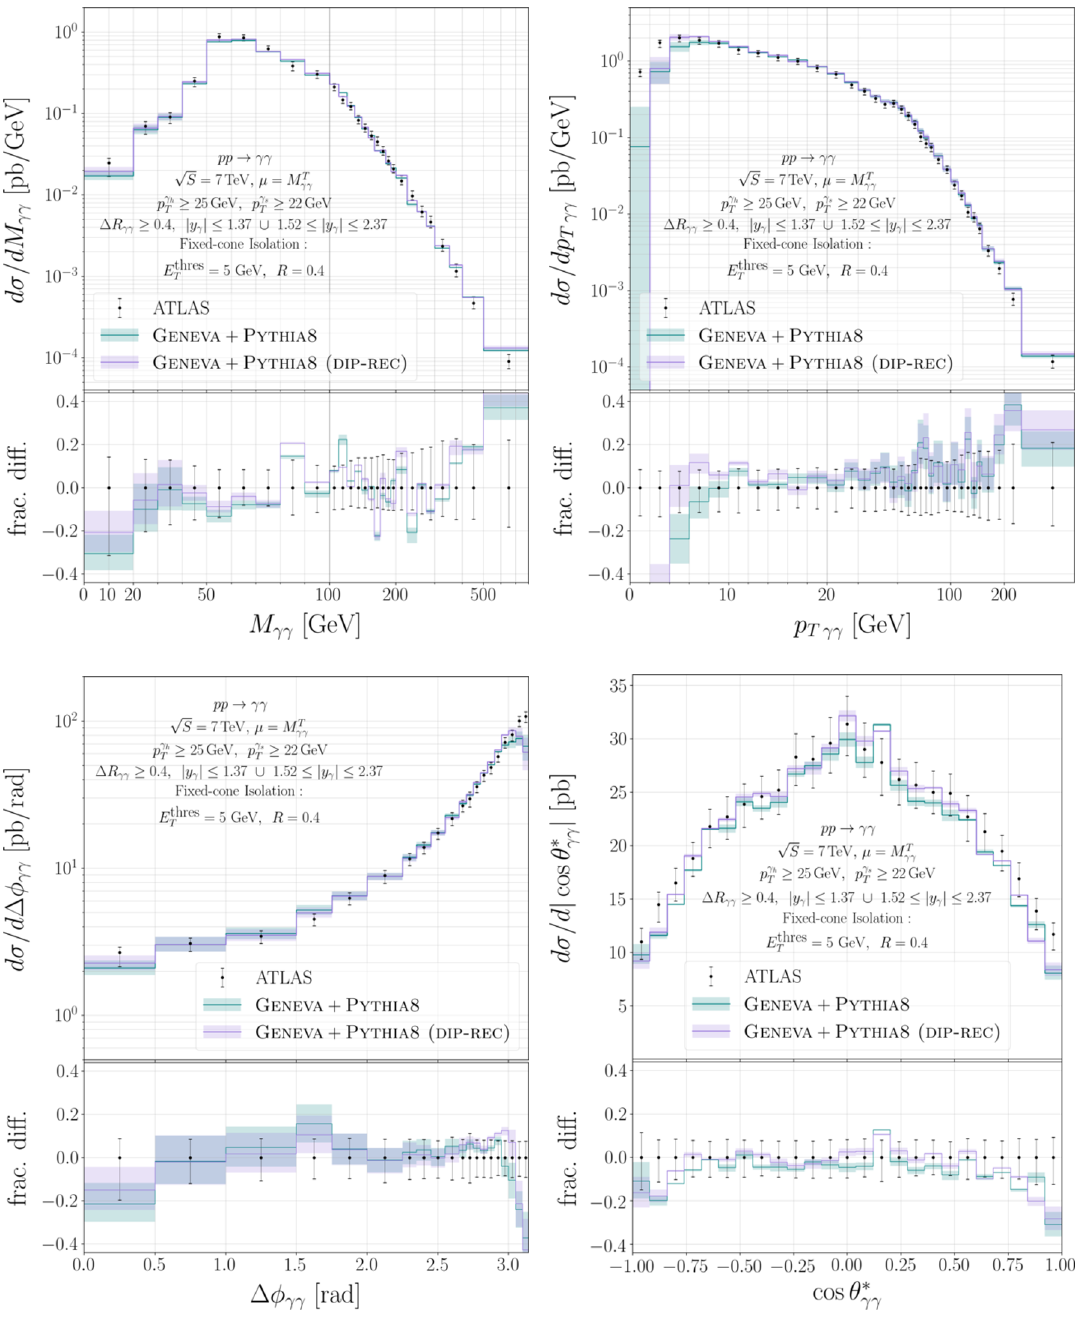
Figure 14 . Comparison between Geneva + Pythia8 and the 7 TeV data from ATLAS [6]. The theoretical predictions have been produced by applying the Rivet analysis ATLAS_2012_I1199269 to the hadronised events. We show the invariant mass of the photon pair (top left), the transverse momentum of the diphoton system (top right), the azimuthal-angle separation between the two photons (bottom left) and the cosine of the polar angle in the Collins-Soper frame of the diphoton system (bottom